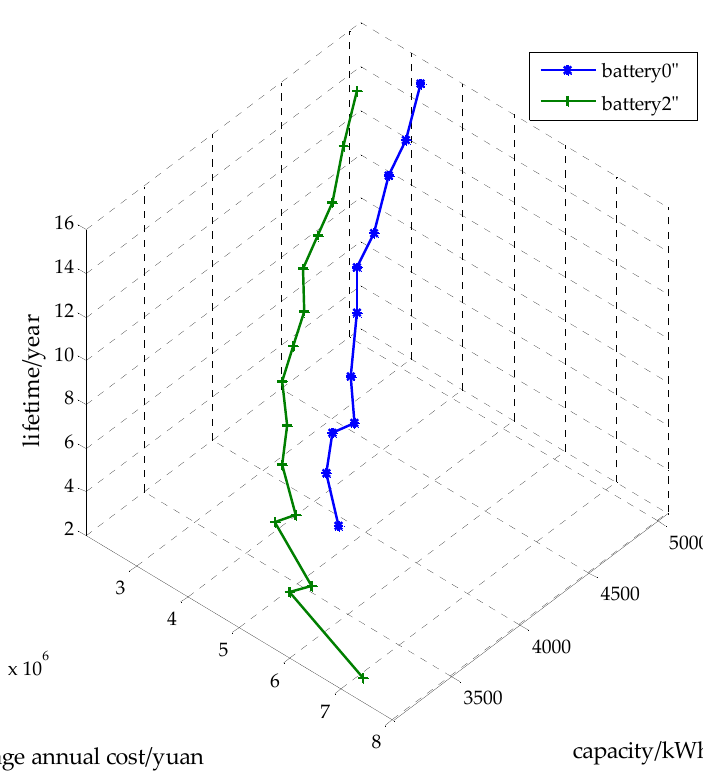
Figure 13. The relationship of the capacity, lifetime, and average annual cost of the ESS.